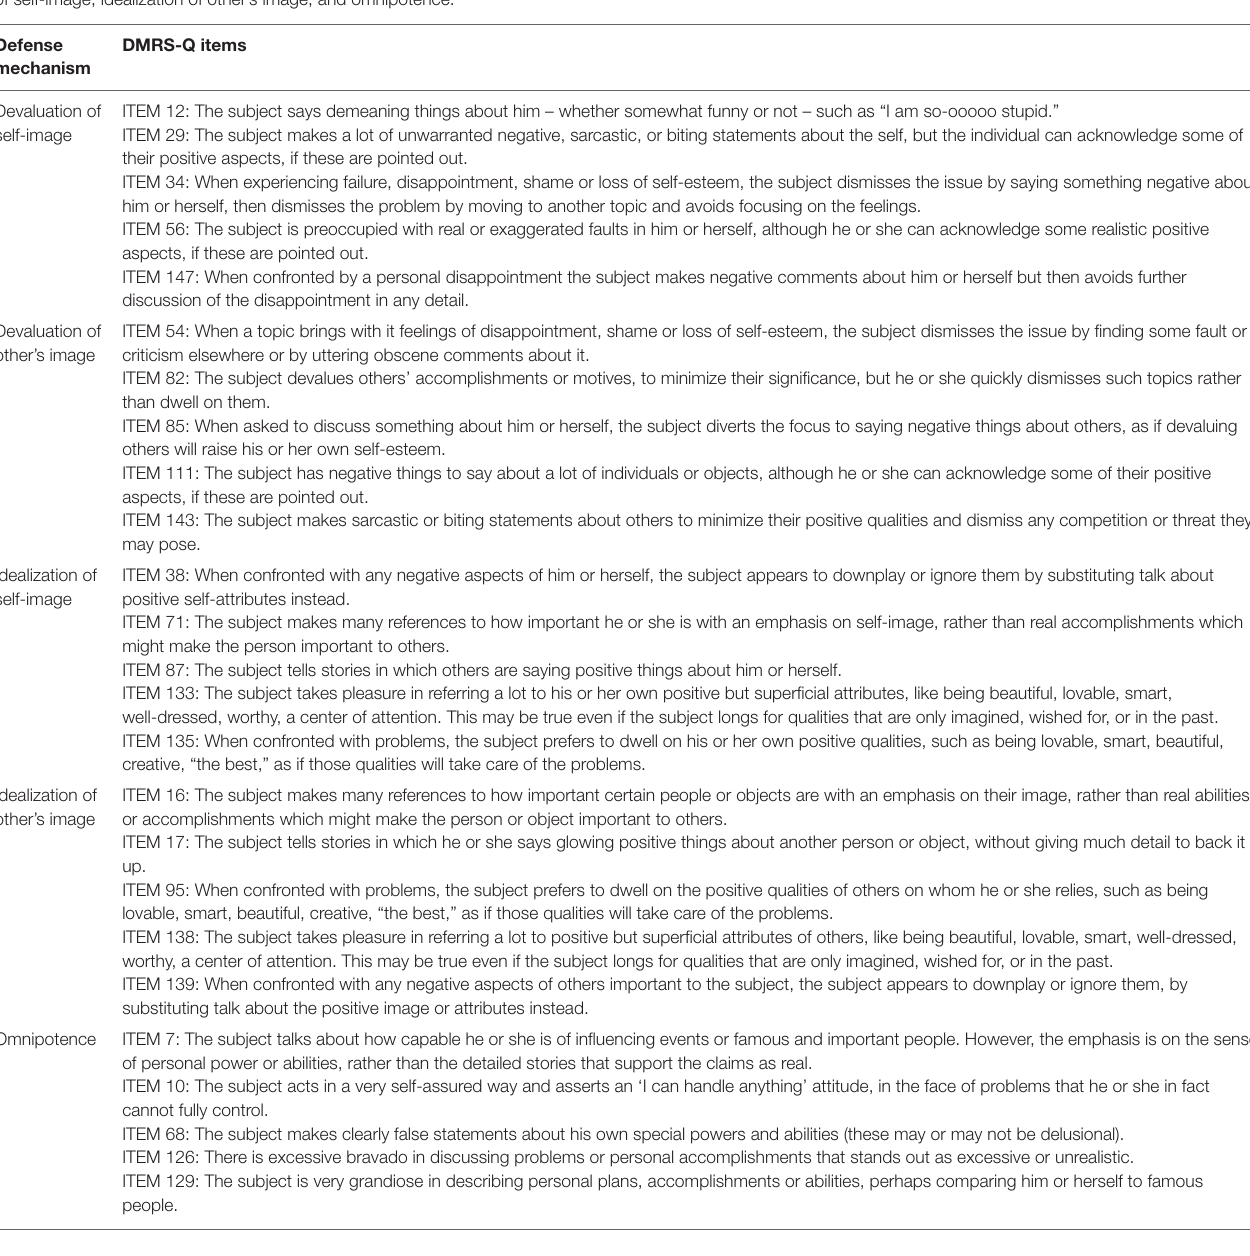
TABLE 5 | Minor image-distorting defense level: Definition, function and DMRS-Q items of defenses devaluation of Self-image, devaluation of other’s image, idealization of self-image, idealization of other’s image, and omnipotence. Defense DMRS-Q mechanism